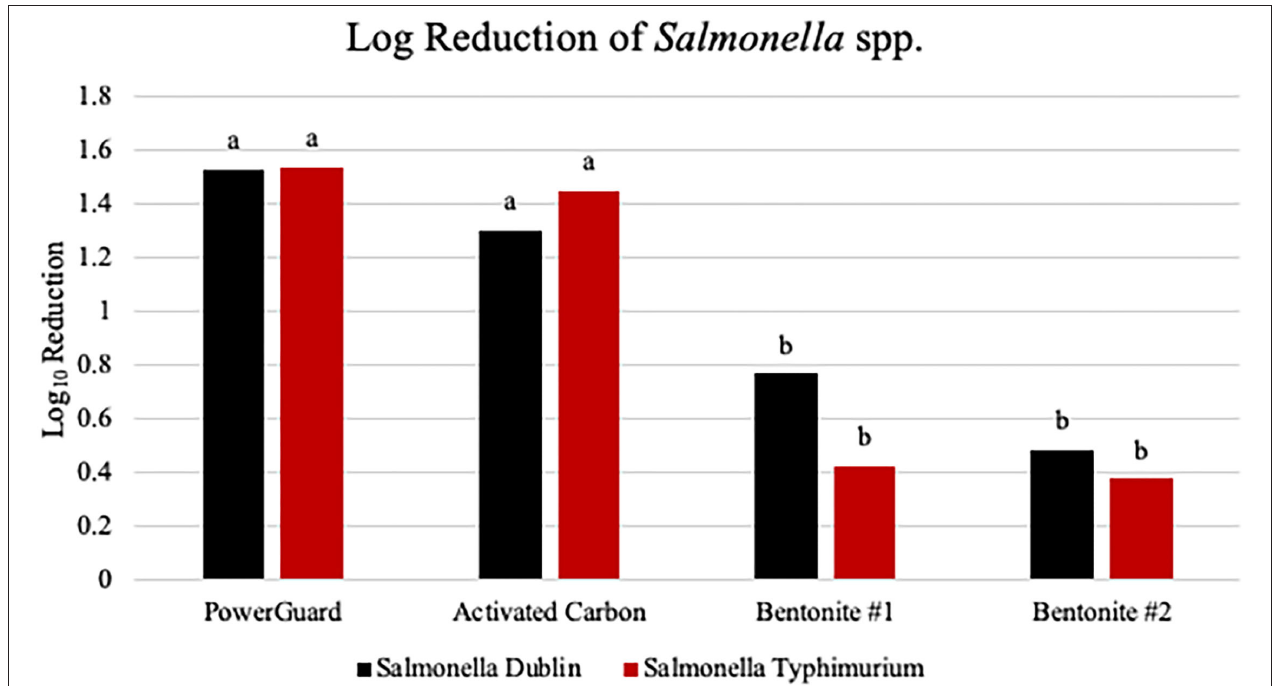
FIGURE 1 | Measures of the capacity for different adsorbents to reduce bacteria concentrations, reported as log 10 reduction, in final filtrate for Salmonella enterica serotypes Dublin and Typhimurium. There was no adsorbent treatment × S. enterica serotype interaction ( P = 0.6 96). However, there was an adsorbent treatment difference for log 10 reduction of both Salmonella enterica serotypes ( P < 0.0001). The largest scanning electron microscopy (SEM) is reported as log 10 reduction and is 0.2123. Bars with different superscripts are statistically different ( P < 0.05).